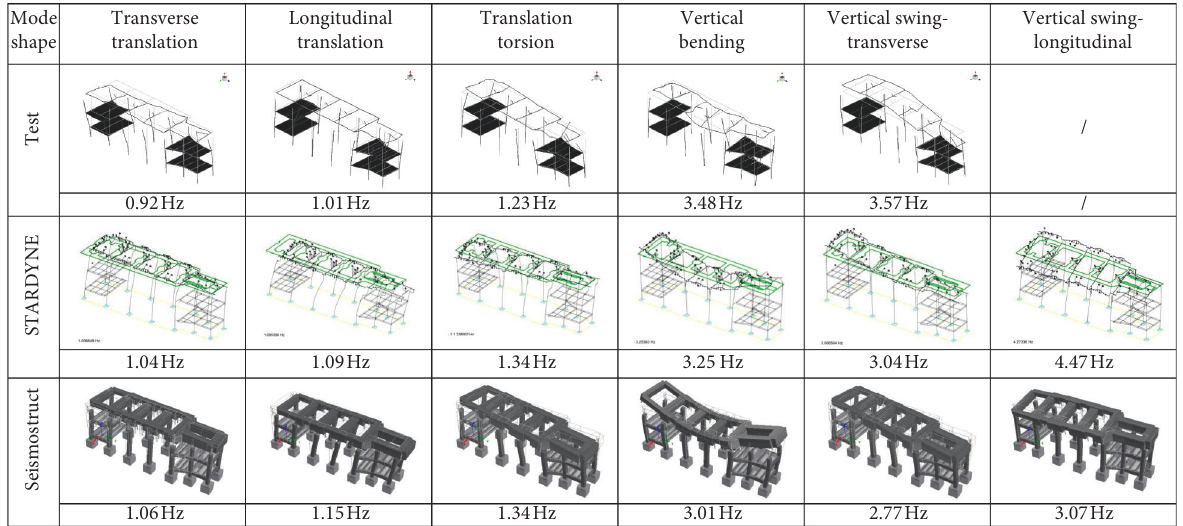
Figure 11: Modal shape contrast of test and Table 6: Max values of seismic response.